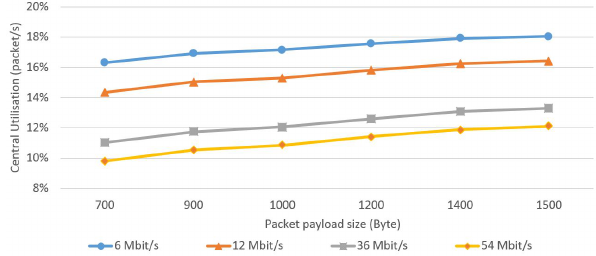
Figure 12: Channel utilisation of each central (Scenario 3.)